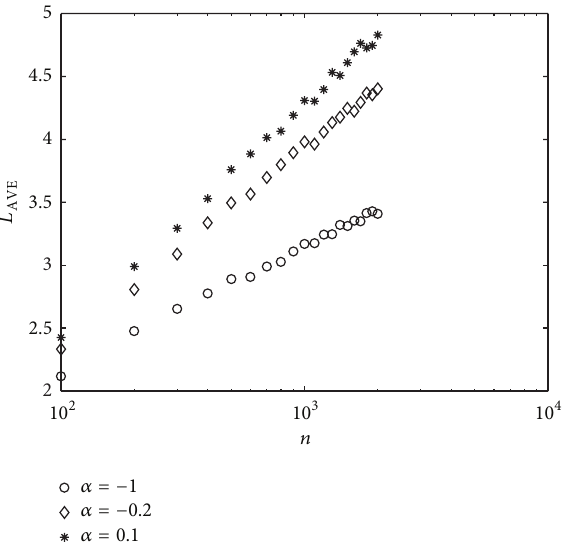
Figure 7: 𝐿 versus 𝑛 . BBV network with 𝛿 = 6 , 𝑚 = 6 , and AVE = 1 . 𝜔 0